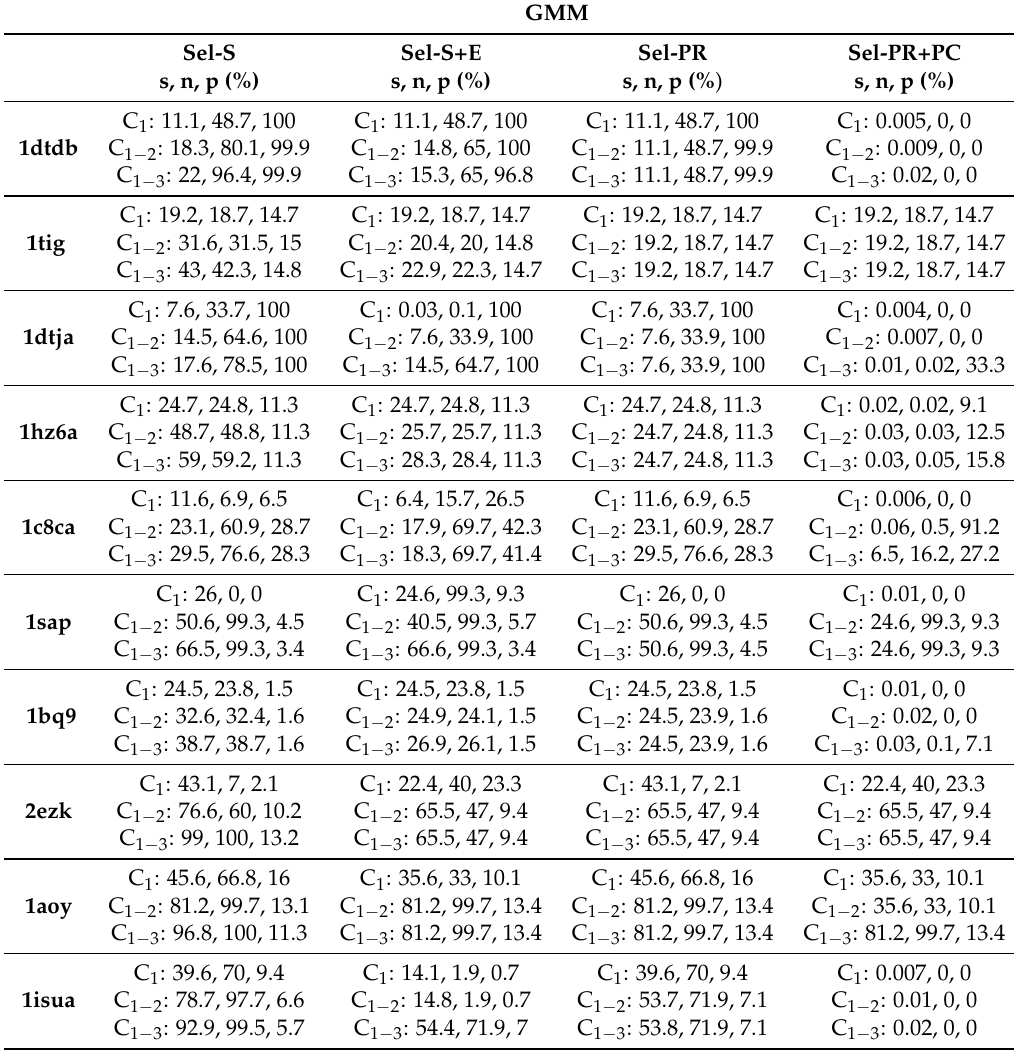
Table 4. The s , n , p of the communities selected by different strategies over communities identified by the Greedy Modularity Maximization (GMM) algorithm on decoy datasets embedded as undirected